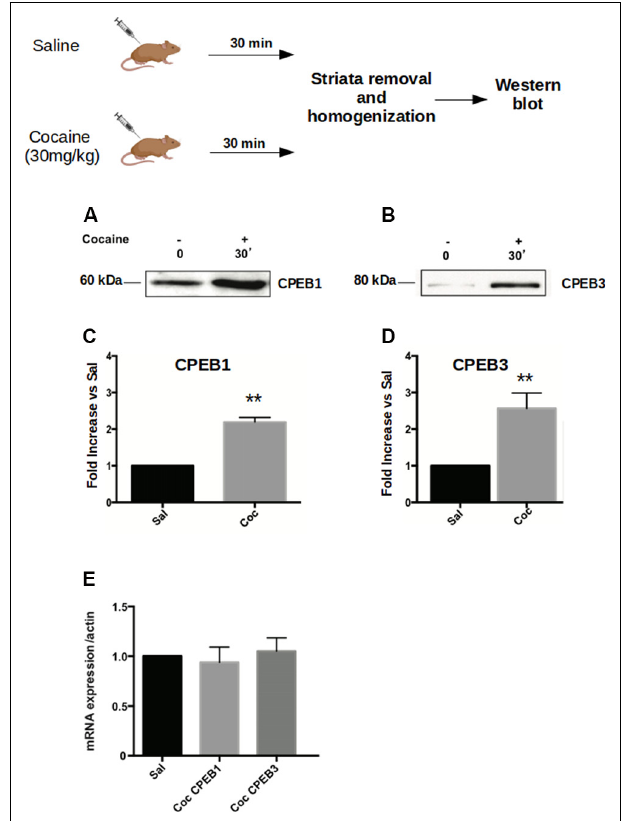
FIGURE 1 | Cocaine administration induces Cytoplasmic Polyadenylation Element-Binding (CPEB3) upregulation in the nucleus accumbens (NAc). Striata of mice ( n = 4) injected with 30 mg/kg of cocaine were analyzed 30 min after cocaine administration in a western blot assay. We found that the expression of CPEB1 and CPEB3 proteins increased considerably following an acute cocaine injection ( A–D , p < 0.01). The increase in CPEB3 protein expression 30 min after an acute cocaine treatment is not transcriptionally dependent but is translationally driven. RT-PCR experiments revealed no significant differences in CPEB genes upregulation 30 min following cocaine exposure (E) . ** p <